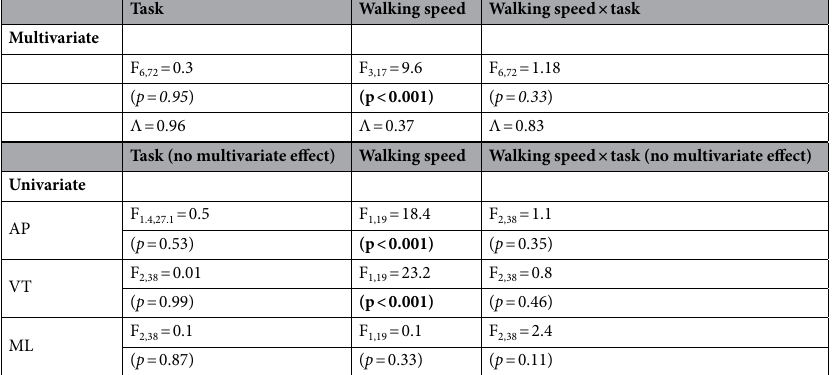
(Table 2). Post hoc analysis using a Bonferroni adjustment indicated that this significant decrease was only evi- dent when walking while texting was compared with walking in the single task condition (Fig. 2).